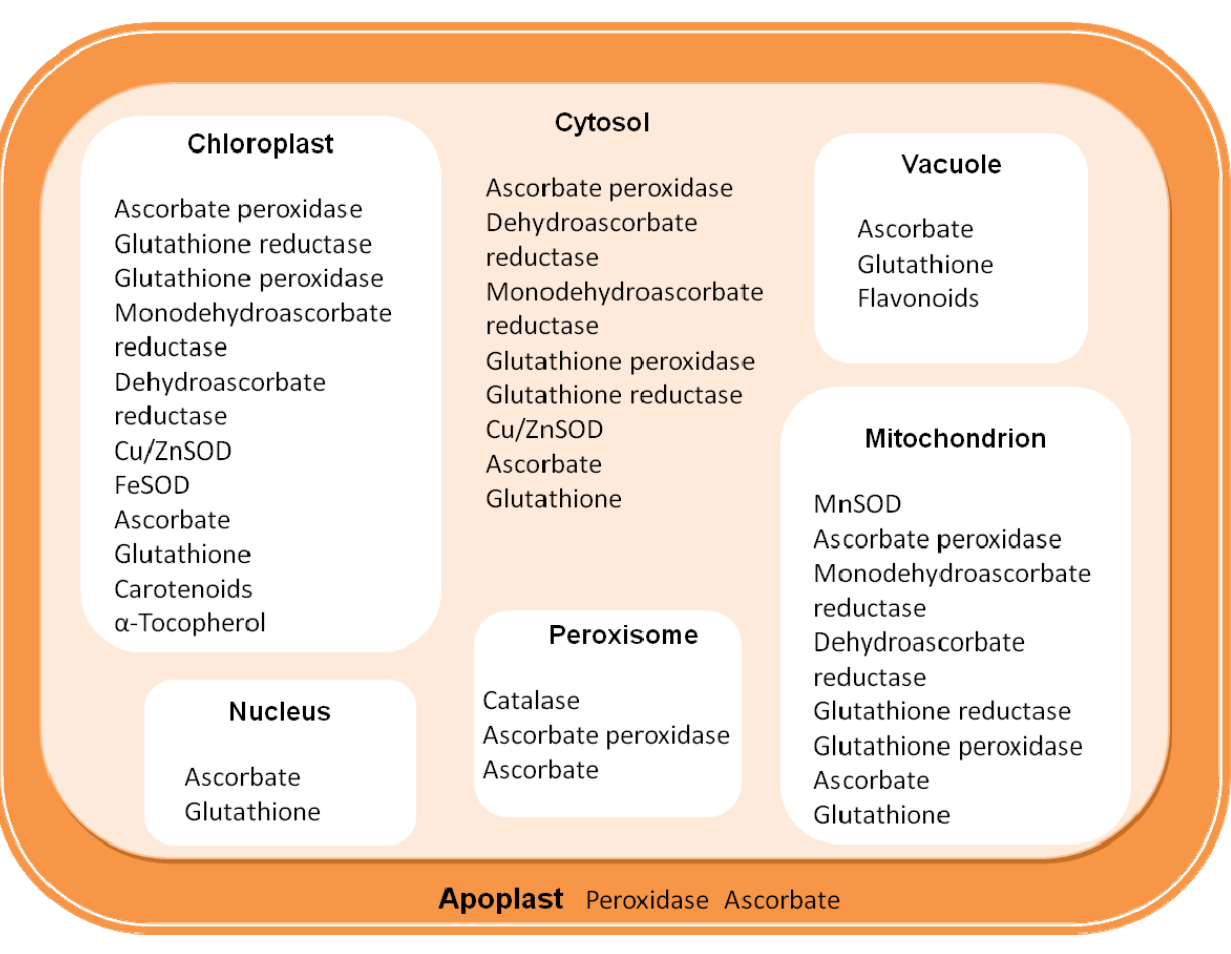
Figure 1. Distribution of the main antioxidant resources in plant